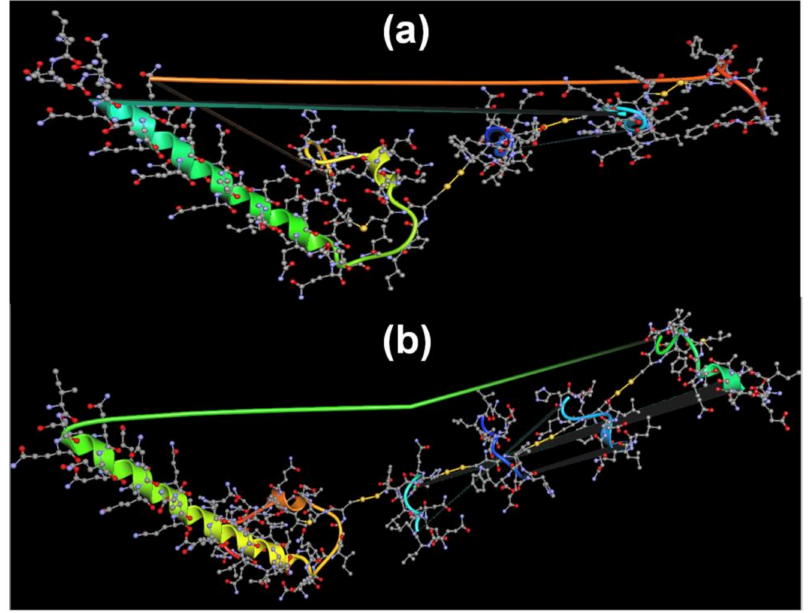
Figure 7. Predicted 3D structure of stigmergized peptides of ( a ) 11.8 and ( b ) 13.8